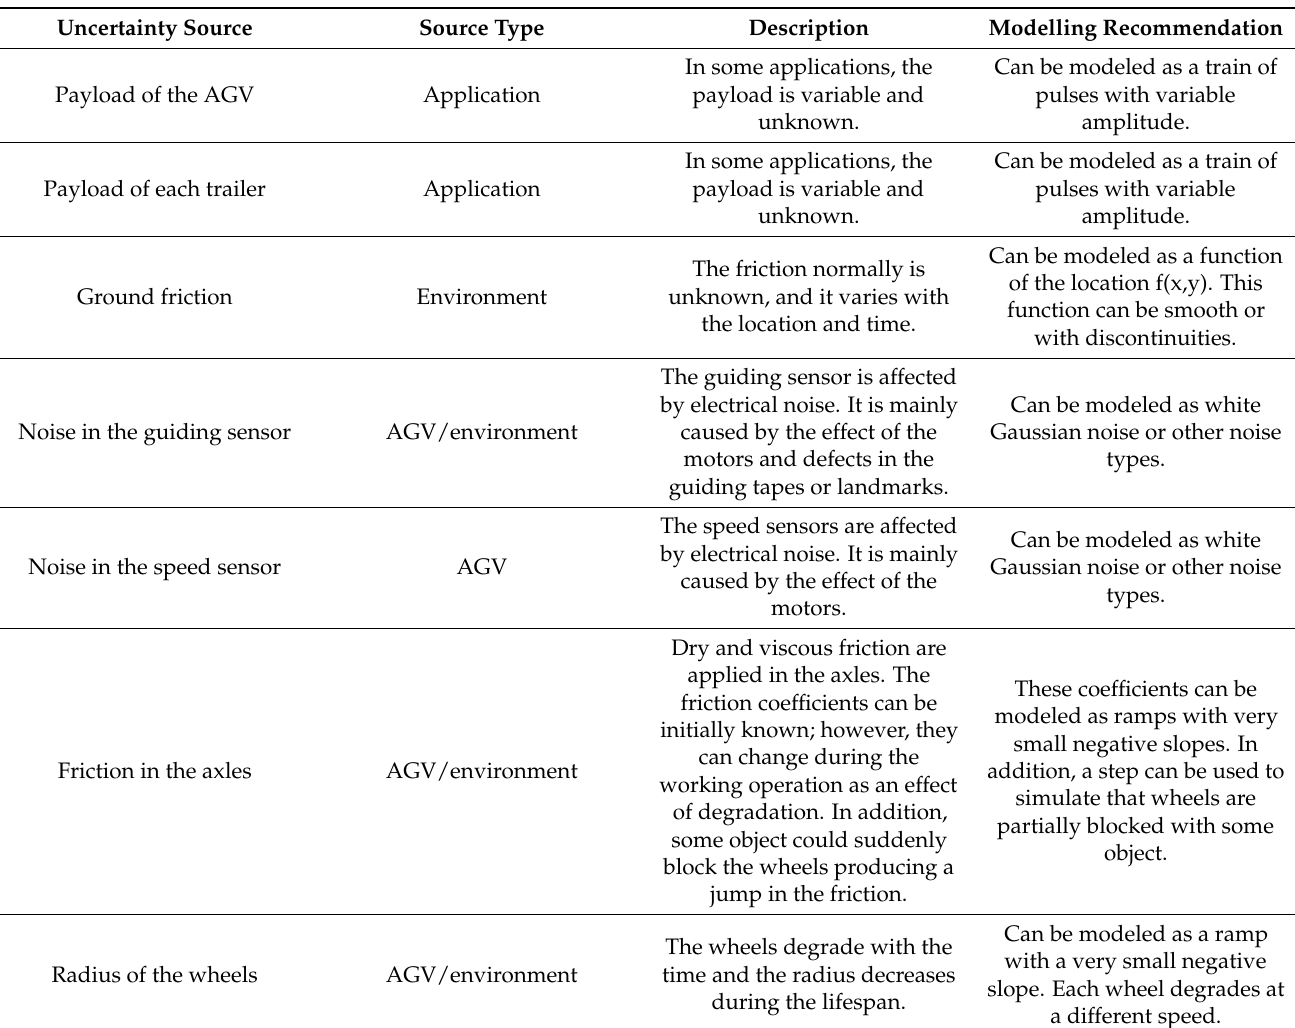
Table 2. Uncertainty sources in the